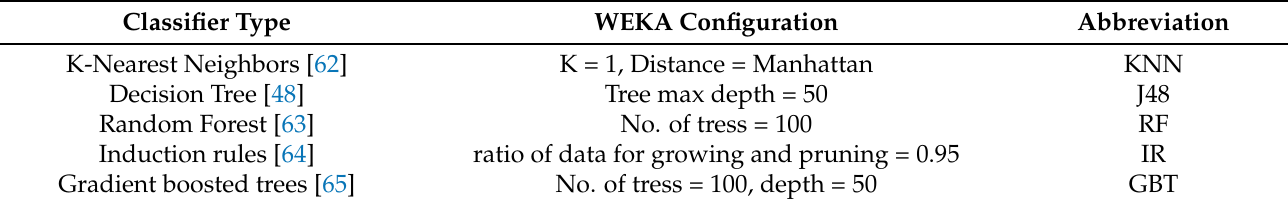
Table 6. Classification algorithms used to evaluate the performance